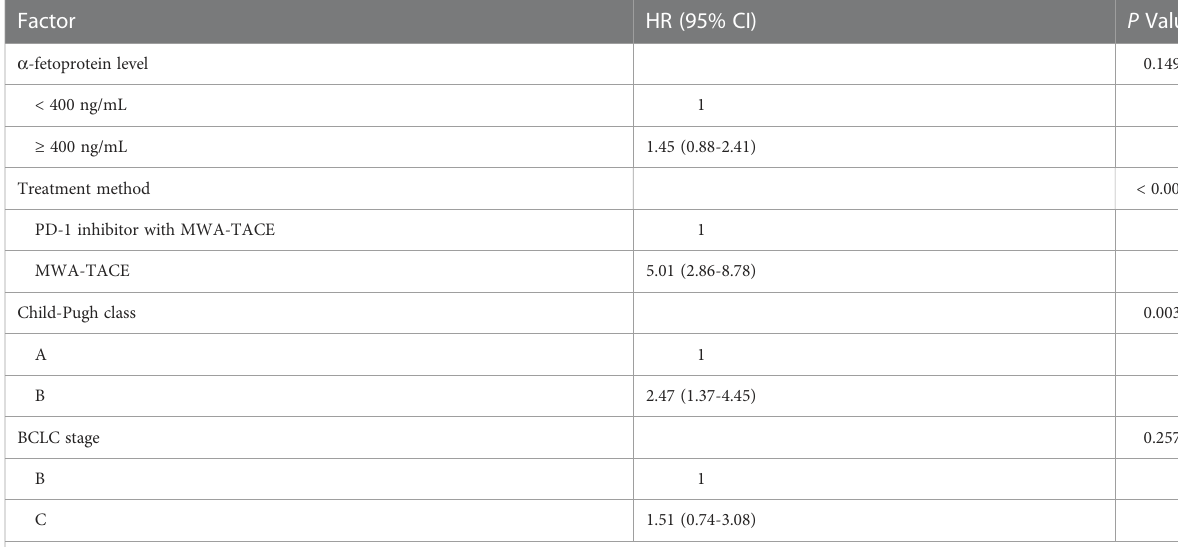
TABLE 5 Multivariate Analysis of Prognostic Factors for Overall